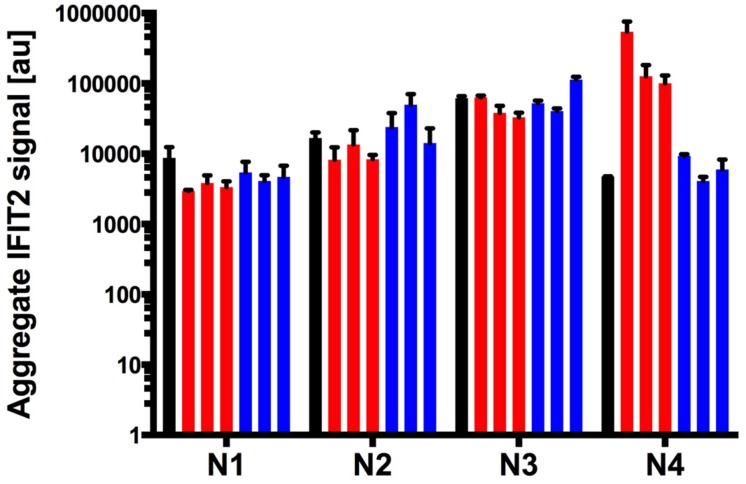
Nucleocapsid rearrangement strains and their evolved variants display differing capacity to suppress host cell innate immunity. Activation of host innate immunity was detected with a PC-3 IFIT2-ZsGreen stable reporter cell line. Induction of IFIT2 was measured as an aggregate signal metric defined in materials and methods. Ancestor populations for each N rearrangement are shown in the black bars, each of the three PC-3 and LNCaP evolved strains are shown in blue and red respectively. Error bars represent the SD of 3 biological replicates.